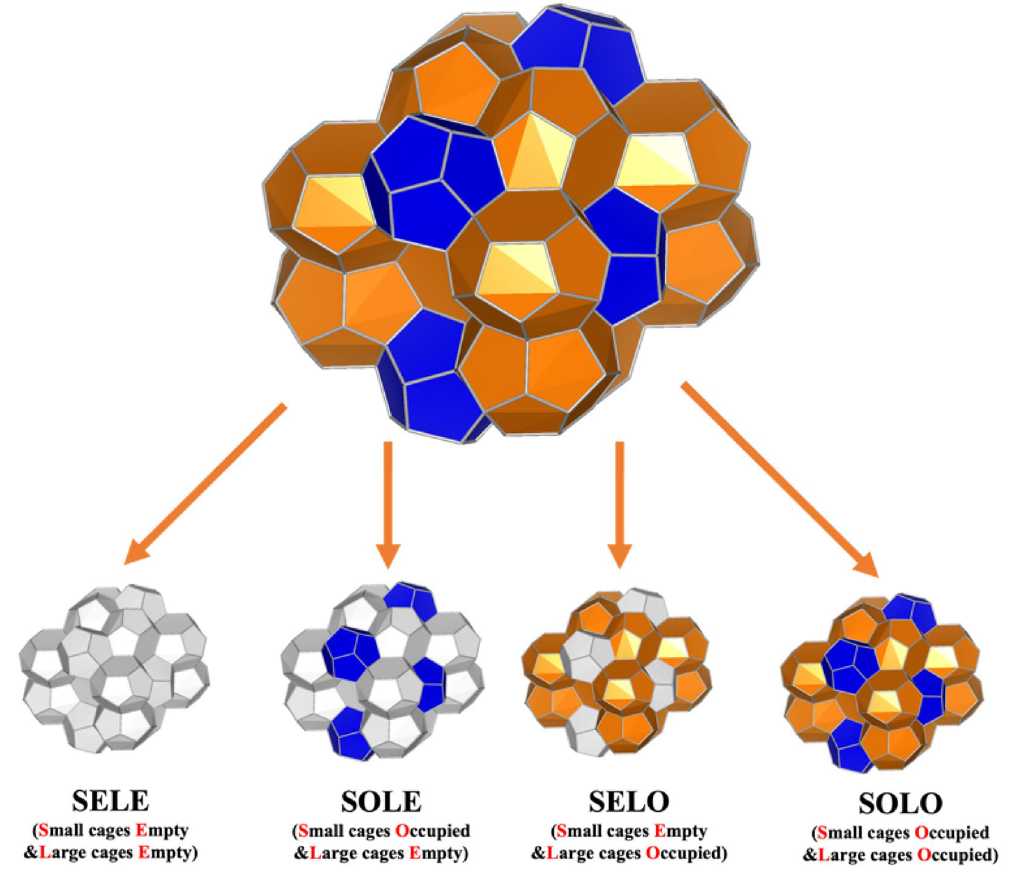
Figure 1. sI gas hydrate’s structure colored according to their cage types. The occupied large cages are shown in orange, the occupied small cages are shown in dark blue, and the empty cages are shown in white. Four different occupancies are shown. They are SELE (small cages empty and large cages empty), SOLE (small cages occupied and large cages empty), SELO (small cages empty and large cages occupied) and SOLO (small cages occupied and large cages